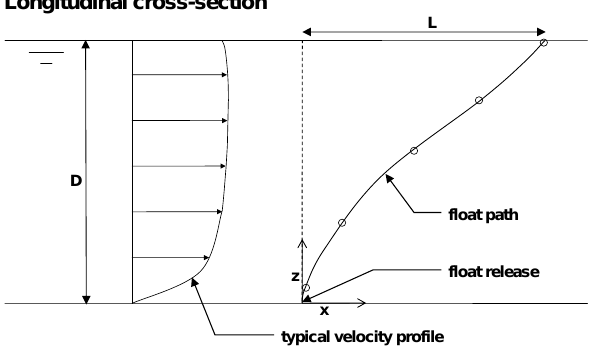
Fig. 2. Float path occurring with a typical velocity profile over depth.